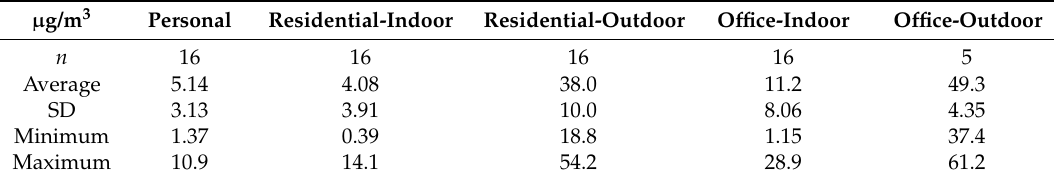
Ozone personal, indoor, and outdoor levels concentration levels during the sampling